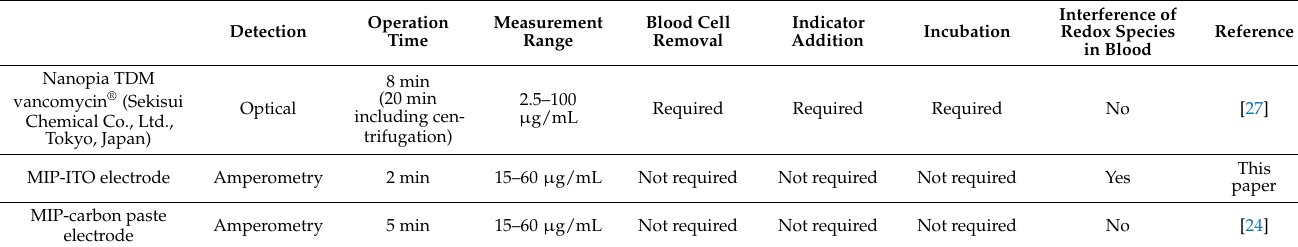
Table 4. Comparison between the MIP-ITO and the conventional assay for TDM.